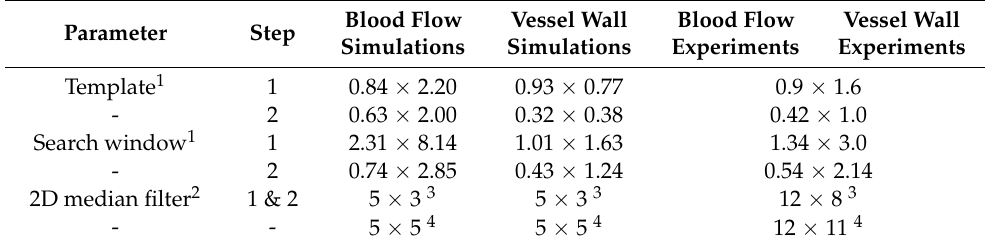
Table 4. Settings for 2-step speckle tracking